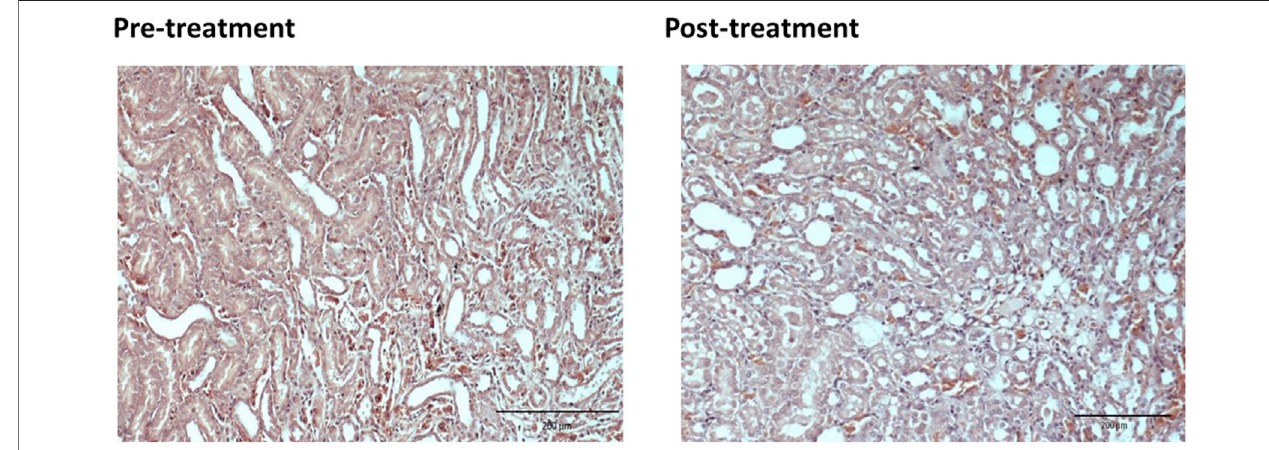
FIGURE 5 | Pre-treatment with EBN 250mg/kg and GTN-mild ATN.